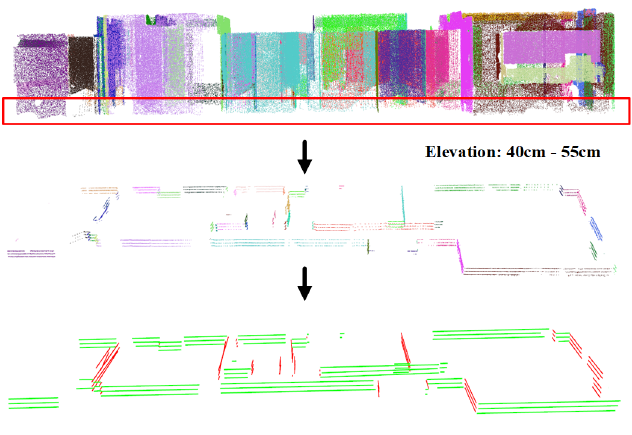
Figure 8. The instance of repetitive layers sharing the same geometry on the vertical direction (truncated elevation from 40 cm to 55